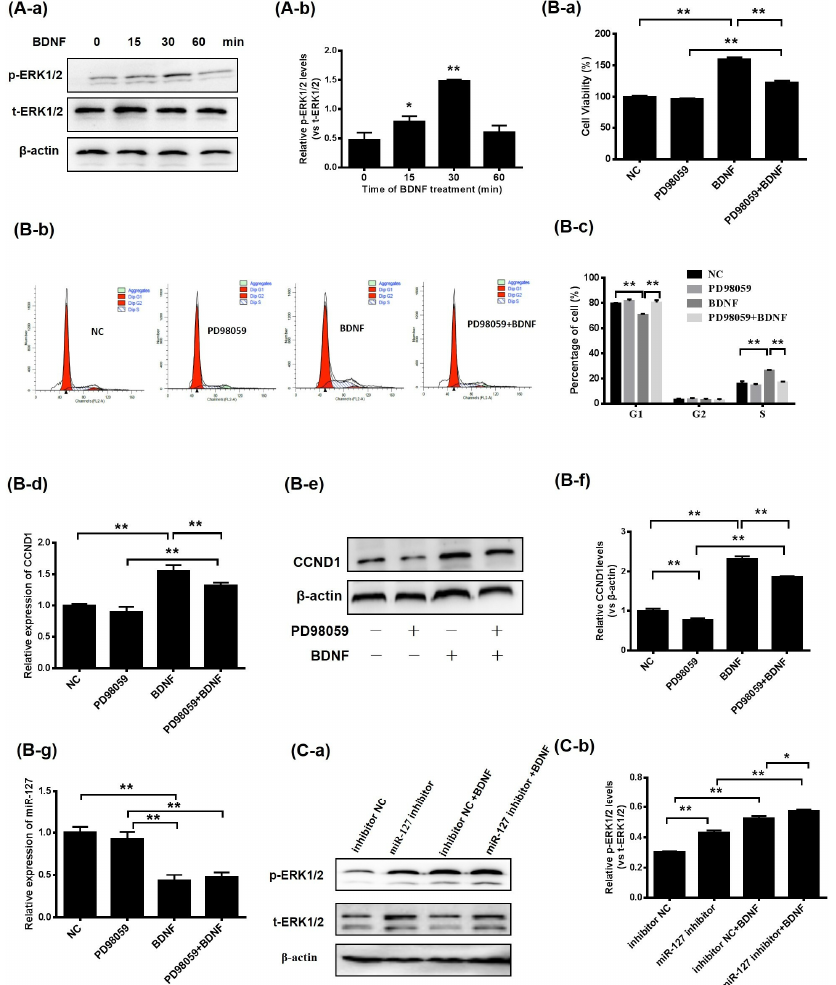
Figure 4. BDNF promotes GC proliferation via the ERK1/2 pathway, mediated by miR ‐ 127. ( A ‐ a,A ‐ b ) BDNF (100 ng/mL) was applied to porcine GCs for 0, 15, 30 and 60 min. Western blotting revealed the presence of the phosphorylation (p ‐ ERK1/2) and total protein (t ‐ ERK1/2) of ERK1/2. ( B ) Porcine GCs are pretreated with PD98059 (15 μ M) for 30 min, before treatment with BDNF (100 ng/mL) for 24 h. The viability of GCs is then investigated using CCK ‐ 8 assay ( B ‐ a ). The cell cycle of GCs is studied using FASC ( B ‐ b , B ‐ c ). Relative mRNA expression ( B ‐ d ) and protein expression ( B ‐ e,B ‐ f ) levels of CCND1 are determined by RT ‐ qPCR and Western blotting. ( B ‐ g ) RT ‐ qPCR is performed to detect the expression of miR ‐ 127. ( C ‐ a,C ‐ b ) The GCs are transfected with miR ‐ 127 inhibitors and